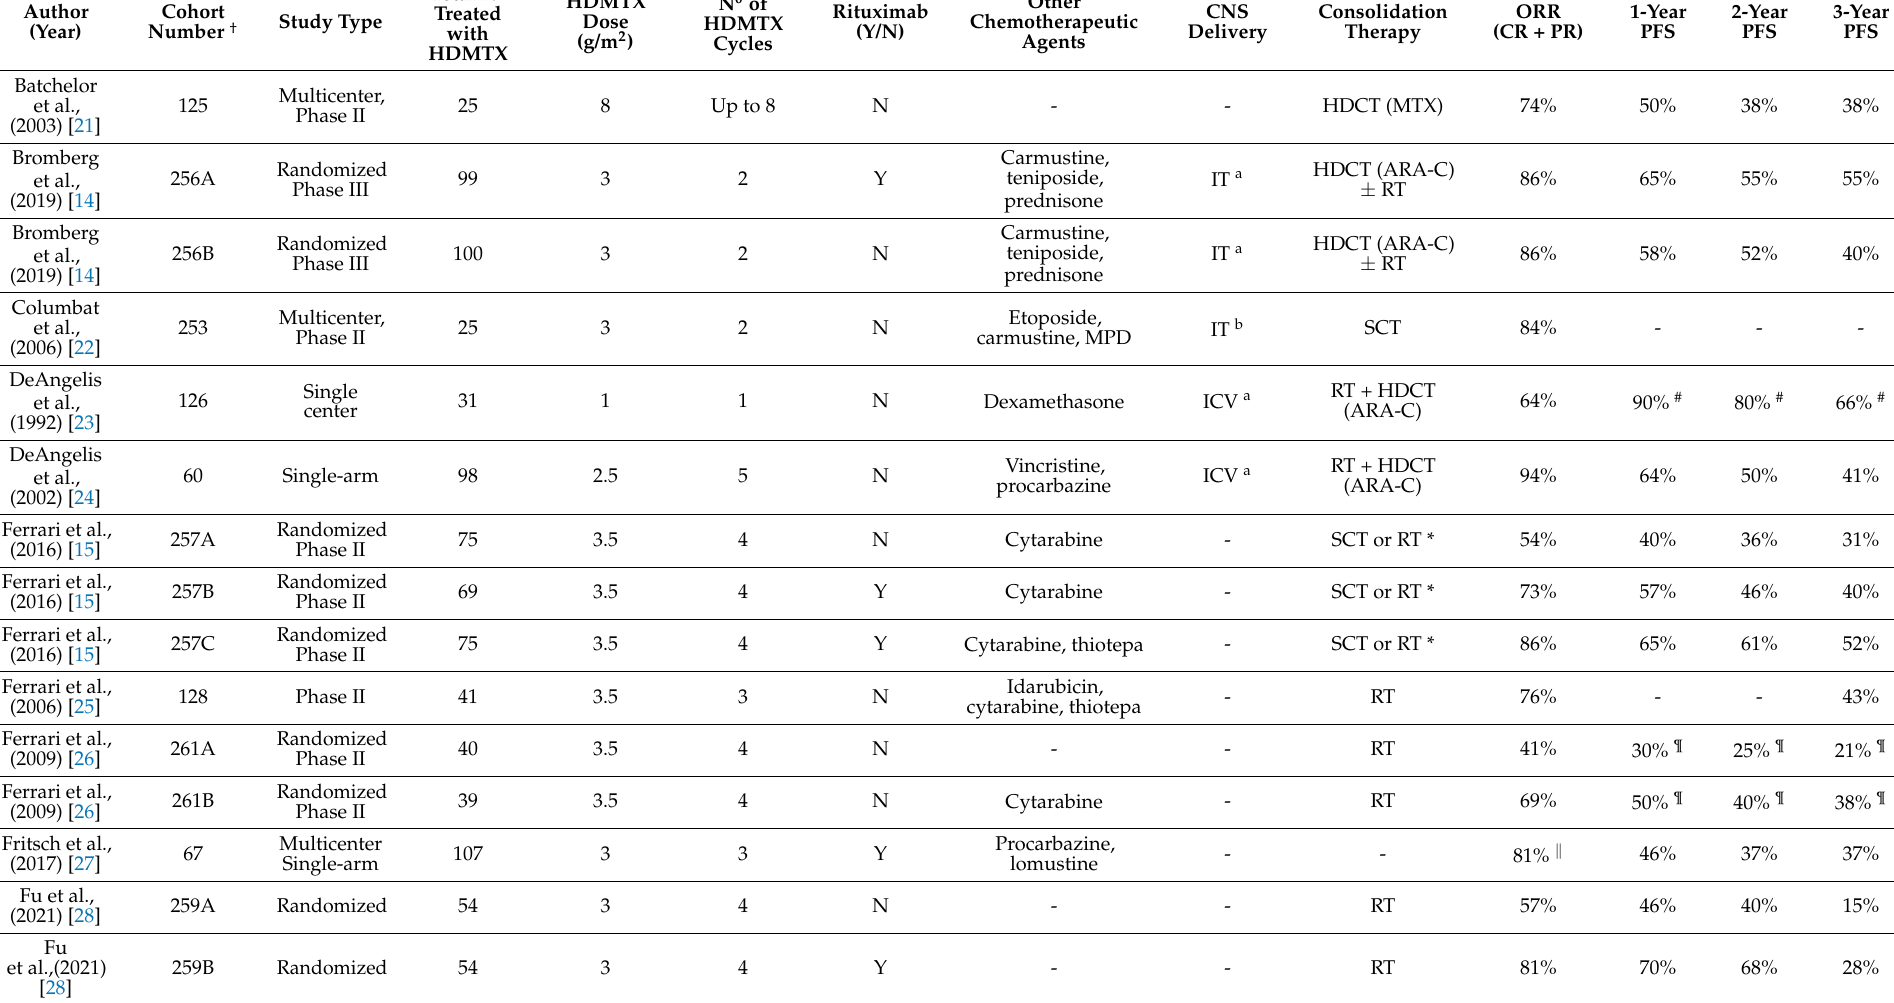
Table 1. Summary of the treatment protocols and characteristics of the analytic